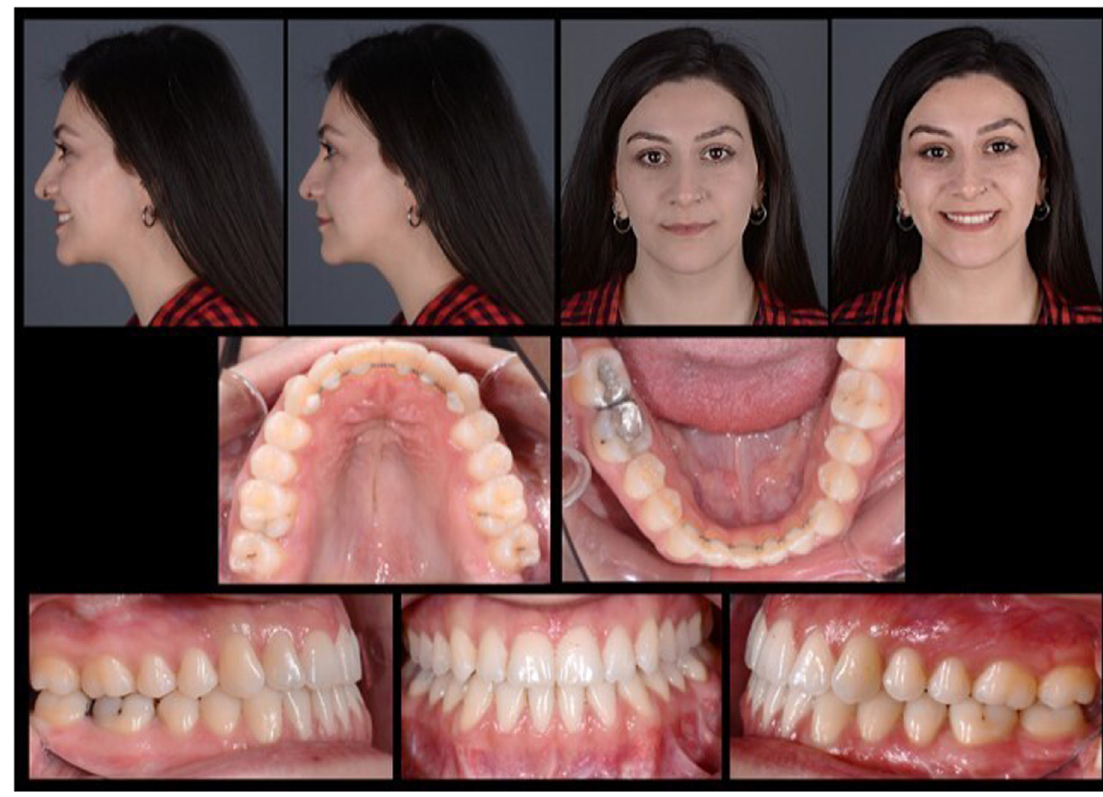
Figure 13. Extraoral and intraoral photographs at one-year